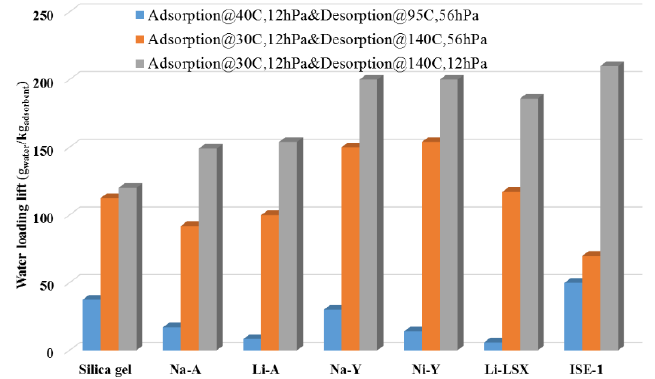
Figure 3. Water loading spread over the cooling cycle for various adsorbents. Reprinted with permission from [54]. American Chemical Society, 2011.